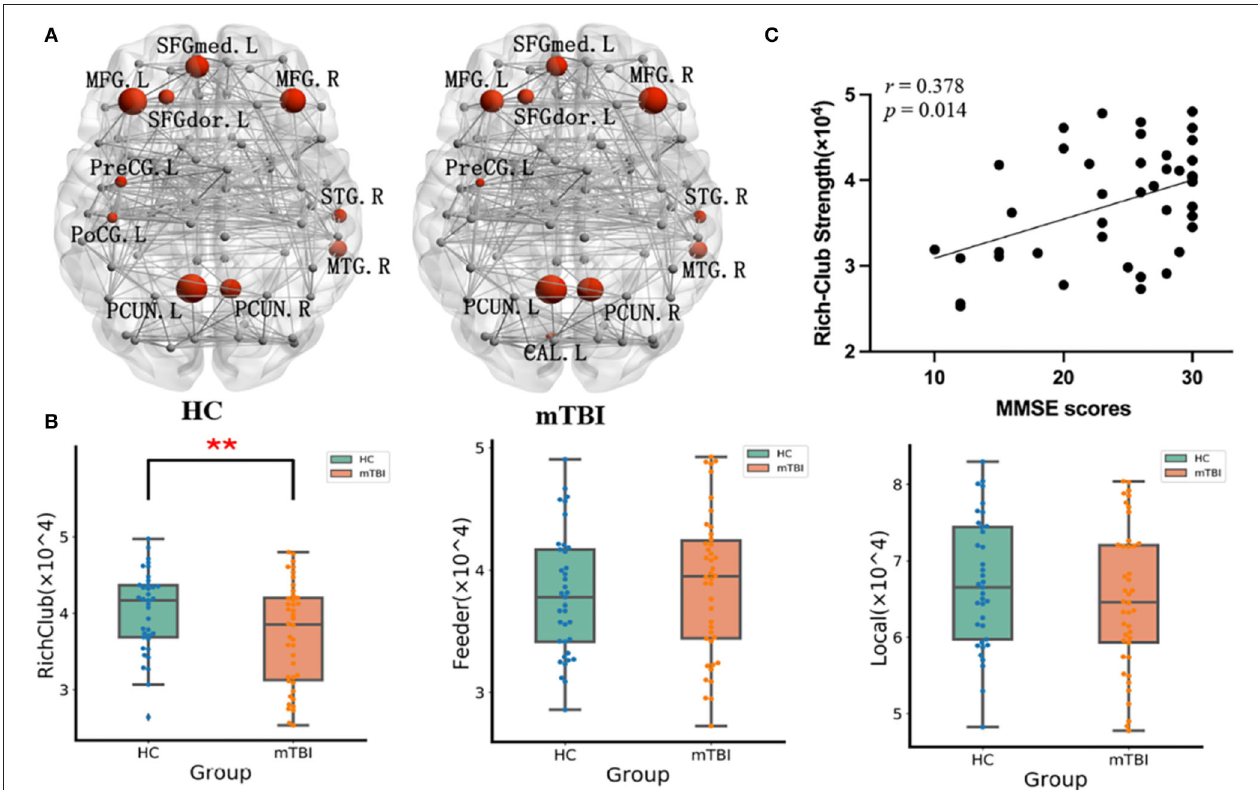
FIGURE 4 | (A) The hubs distribution of the WM networks in the mTBI and HCs group, with hubs colored in red and the hubs sizes indicating the nodal connection strength. PCUN, precuneus; MFG, middle frontal gyrus; SFGmed, medial of superior frontal gyrus; SFGdor, dorsolateral of superior frontal gyrus; PreCG, precentral gyrus; MTG, middle temporal gyrus; STG, superior temporal gyrus; PoCG, postcentral gyrus; CAL, Calcarine fissure and surrounding cortex. (B) The mTBI group showed significantly lower strength of the rich-club connection. The feeder and local connections were no significant change compared with HCs. (C) Correlation between the MMSE score and rich-club connection strength. ** Indicates p < 0.05. mTBI, mild traumatic brain injury; HC, healthy control; MMSE, Mini-Mental State